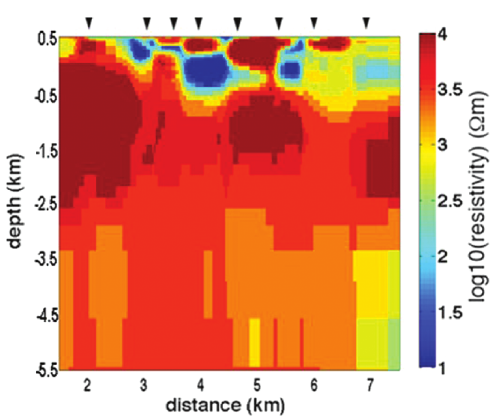
Fig. 7. 2D resistivity ending models obtained by the joint inversion of the CSAMT TM and TE modes, using a homogeneous half-space with resis- tivity ρ 0 =10000 Ω m and τ =1 for the regularization